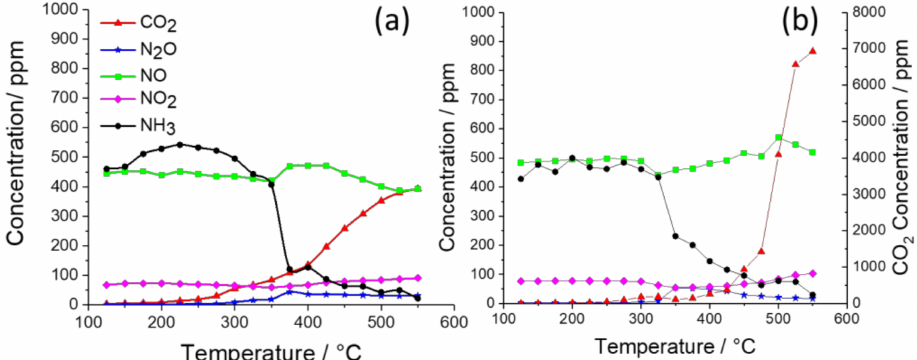
Figure 6. Performance of 2%Ag–15%K/CZA tested in a simulated exhaust gas containing NH 3 as reductant ( a ) in the absence of carbon black, and ( b ) in the presence of carbon black.